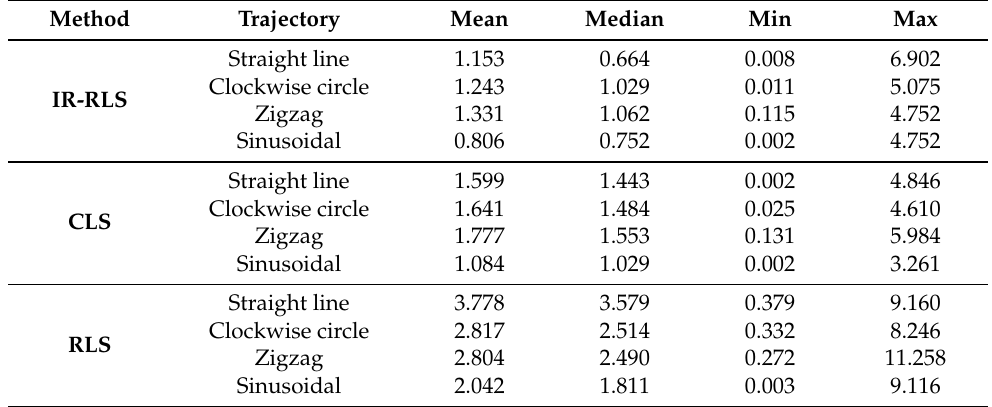
Table 1. Mean, median, minimum, and maximum of RMSE in each trajectory case.